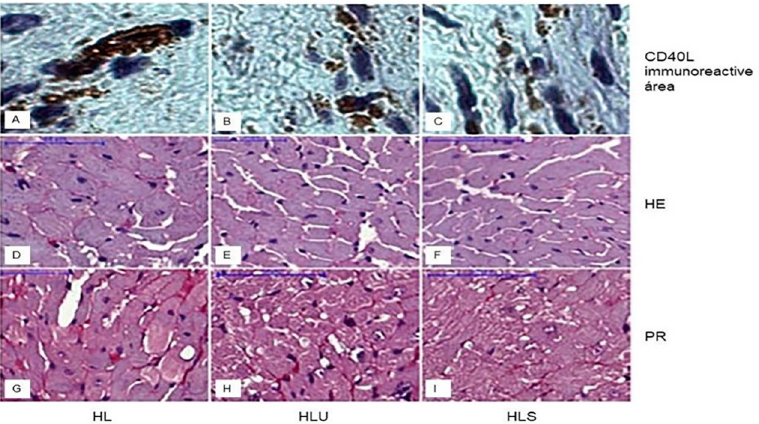
Fig 1. Photomicrograph of transverse histological sections of the left ventricle of mice showing the immunoreactive area for CD40L, cardiomyocyte diameter, and collagen deposition (marked in red). Group HL: received hyperlipid ration; Group HLU: received hyperlipid feed and grape juice; Group HLS: received hyperlipidic ration and